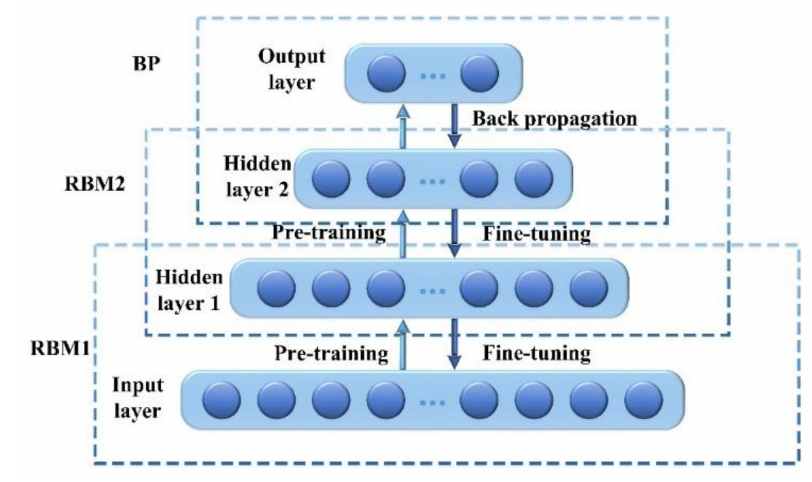
Figure 7. The basic structure of the DBN with 2-layers